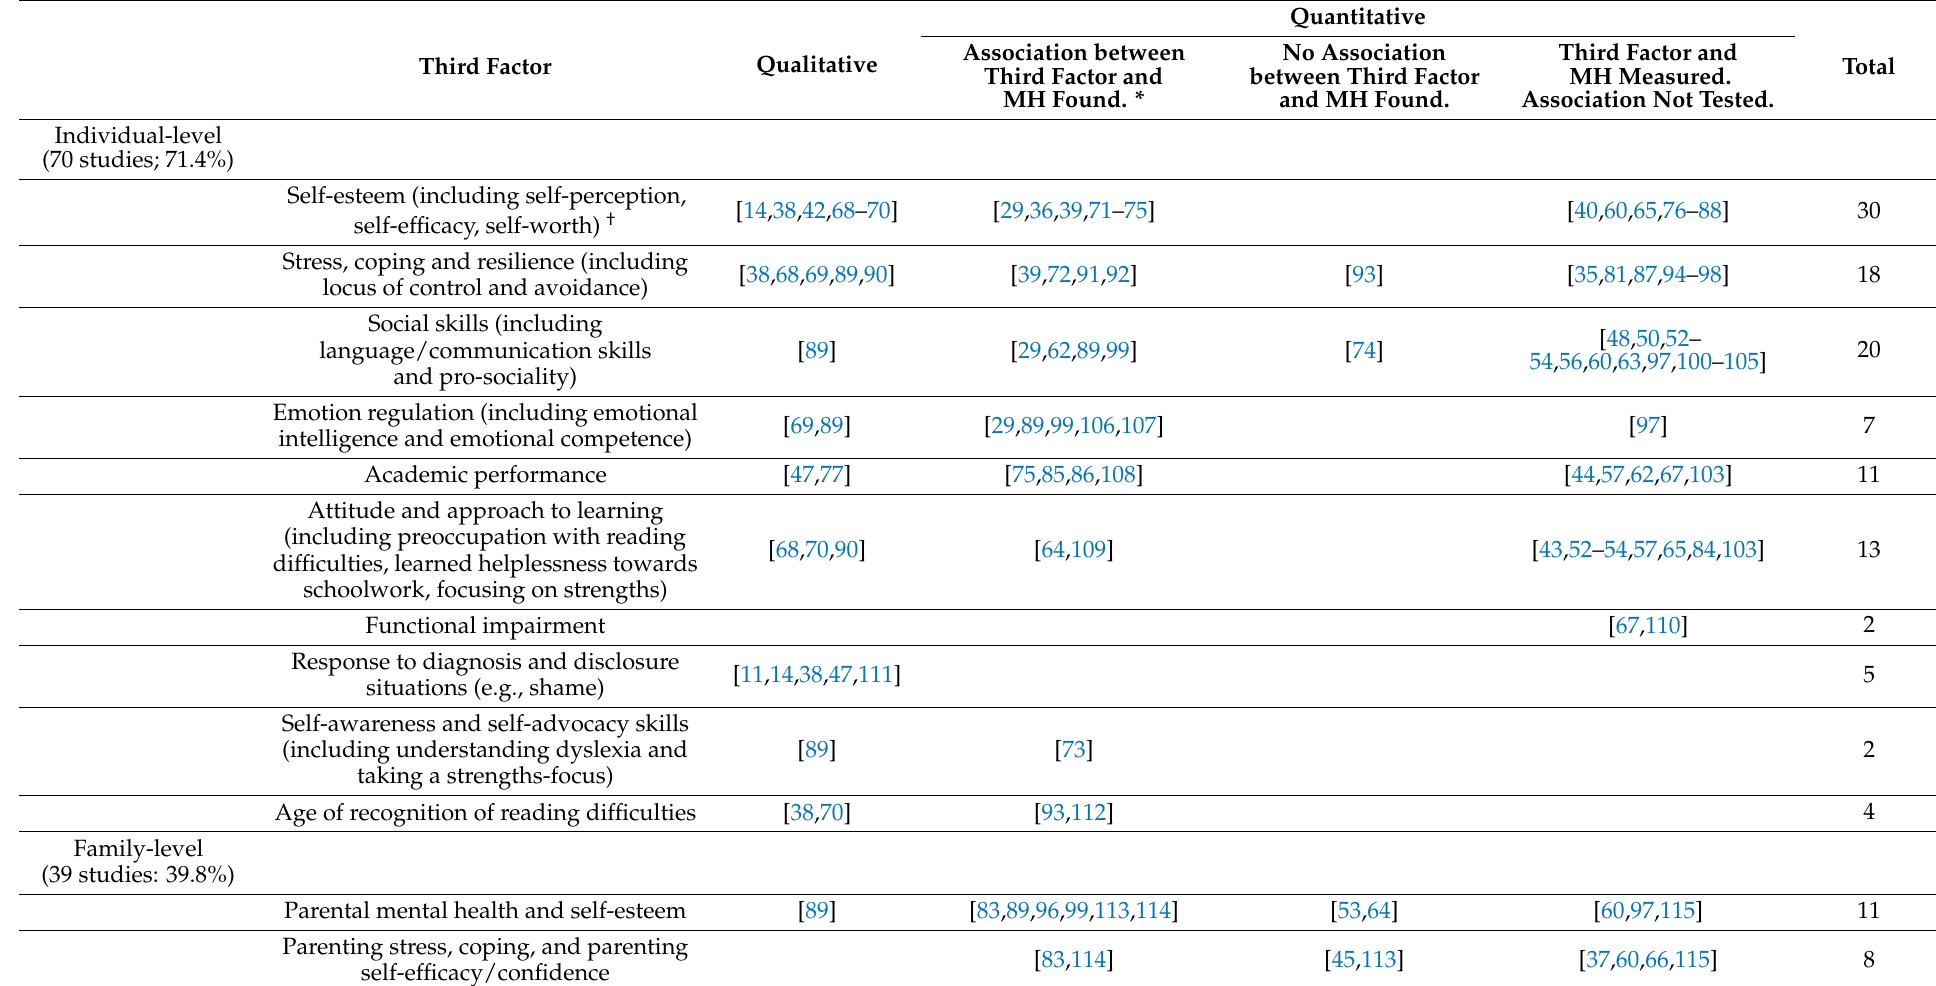
Table 1. “Third factors” and associations with internalising/externalising mental health (MH) concerns among children with reading/learning difficulties. Third Factor Qualitative